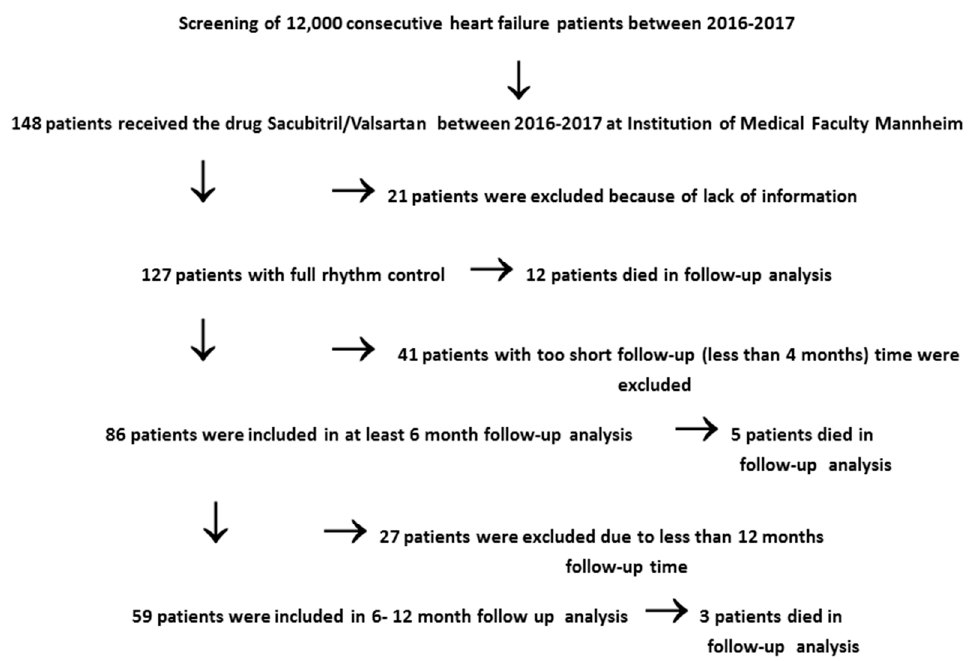
Figure 1. Flowchart presenting the screened data and included patients for the present